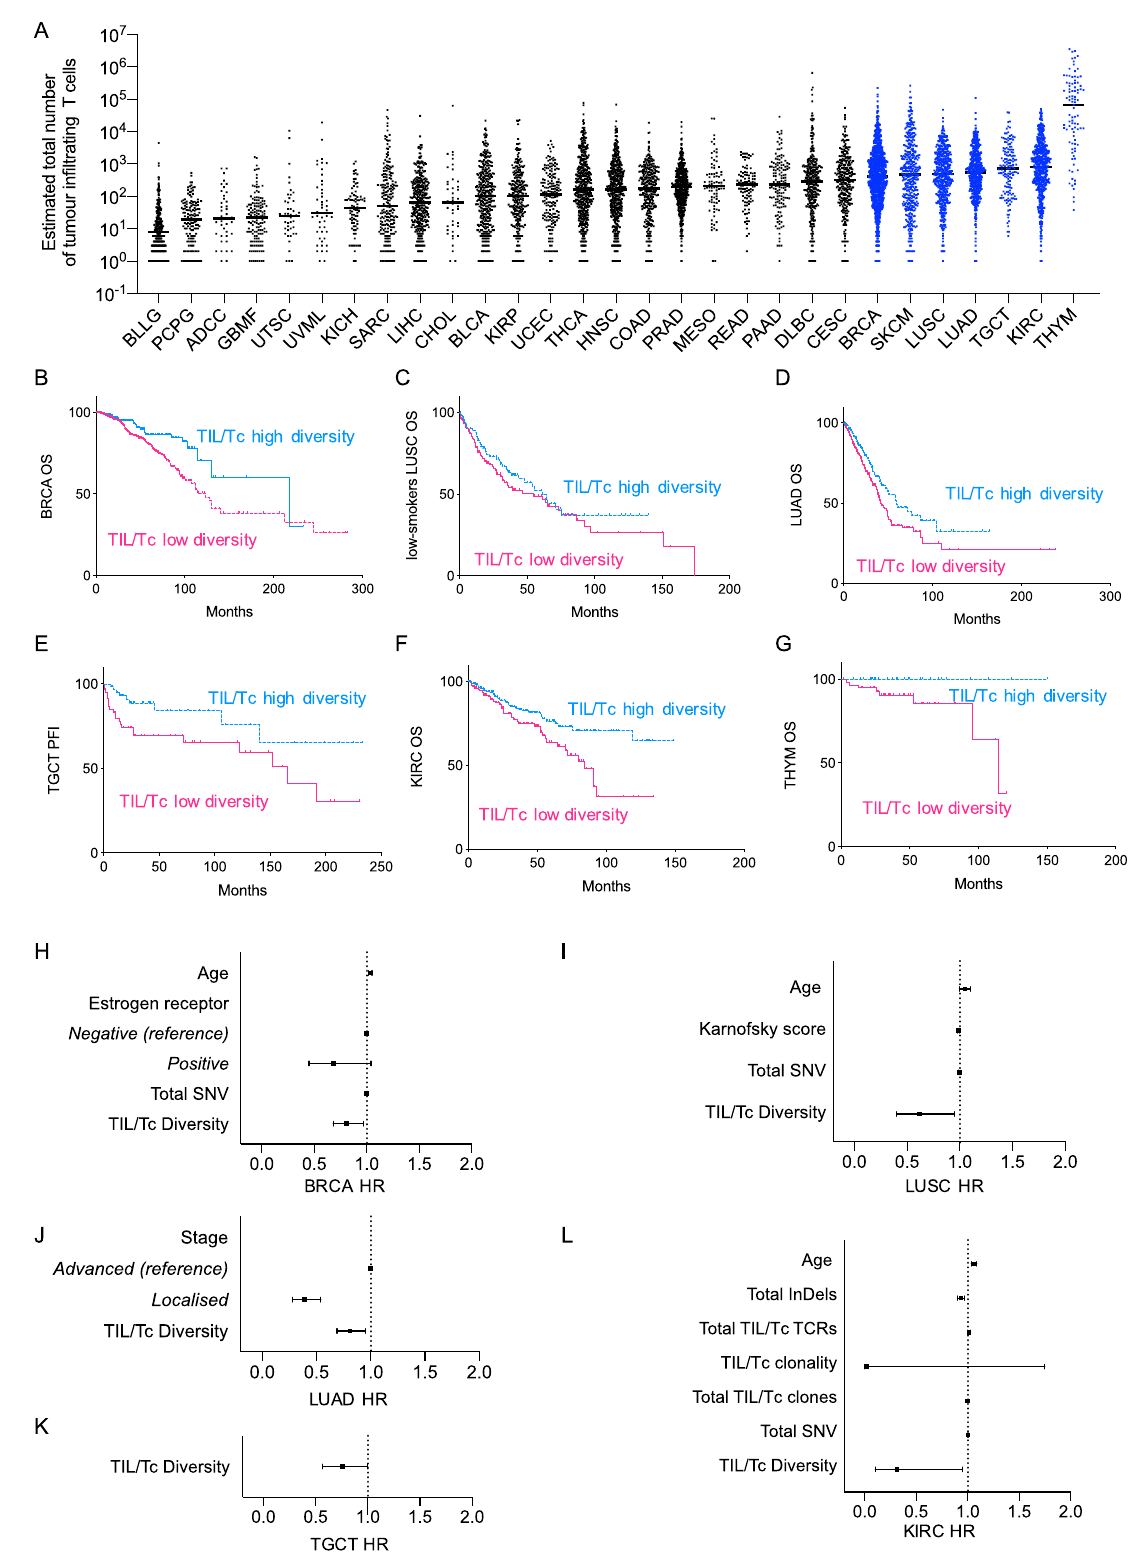
were then quanti fi ed by a clinical pathologist according to good clinical practice guidelines for approved diagnostic PD-L1 quanti fi cation. Statistics and reproducibility . All tests were two-sided and P values < 0.05 were retained as signi fi cant. Unless otherwise speci fi ed, multivariate Cox regression was used to calculate the hazard of death; fast-backward method was applied to